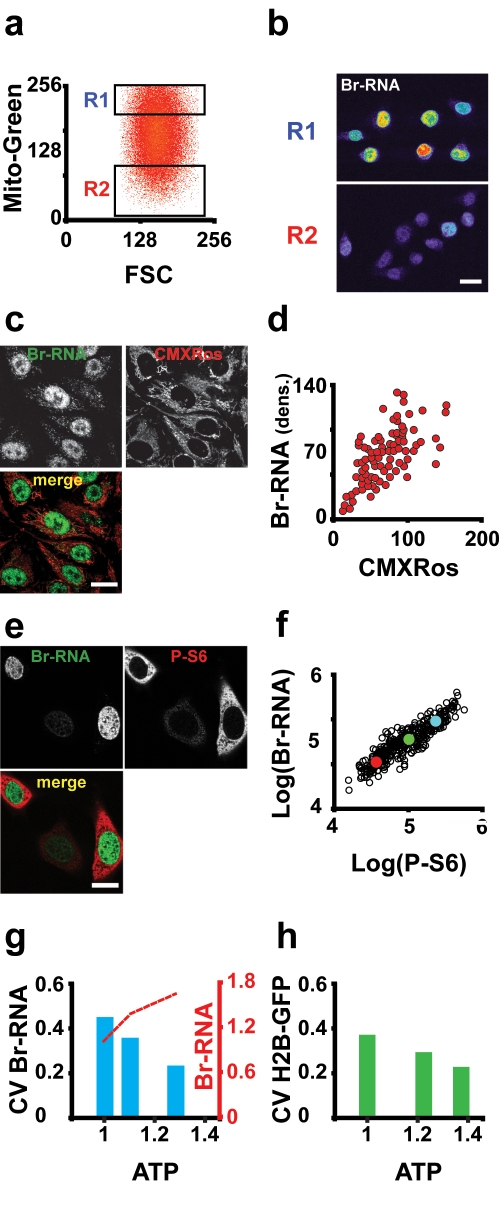
Mitochondria determine transcription elongation speed.(A) Hela cells were sorted according to the mitochondrial content after staining with MitoTracker Green FM. Two populations of cells were sorted, with a difference in mitochondrial content of around 5-fold (R1 and R2). (B) Four hours after plating, cells were incubated with BrU. These experiments show a direct relationship between mitochondrial content and both RNA production and mRNA content (quantification in S8A and S8B). (C) Cells stained with the redox-sensitive mitochodrial probe CMXRos (middle panel) and Br-RNA (left panel). (D) Quantitative analysis of images like that in (C) (arbitrary units). There is a direct relationship between CMXRos and BrU incorporation signals (confocal images). (E) Co-staining of Br-RNA and P-S6 in Hela cells. (F) Nuclear Br-RNA production under conditions of ATP depletion. Cells were incubated with DG for 12 h, and at the end of incubation 5 mM BrU was added. In this plot we superimposed the data points of three different conditions used: glucose (average: blue dot), 25 mM DG (average: green dot), or 50 mM DG (average: red dot). (G) ATP affects CV in BrU incorporation. Intracellular ATP concentration was raised by succinate incubation (5 and 10 mM) for 30 min. The CV of Br-RNA is reduced in a manner proportional to ATP (blue bars), and BrU incorporation increases in parallel to intracellular ATP increase (red dotted line). (H) CV of the speed of exchange of histone H2B–GFP. This reporter behaves very similarly to BrU, decreasing as intracellular ATP increases. Bars = 10 µm.